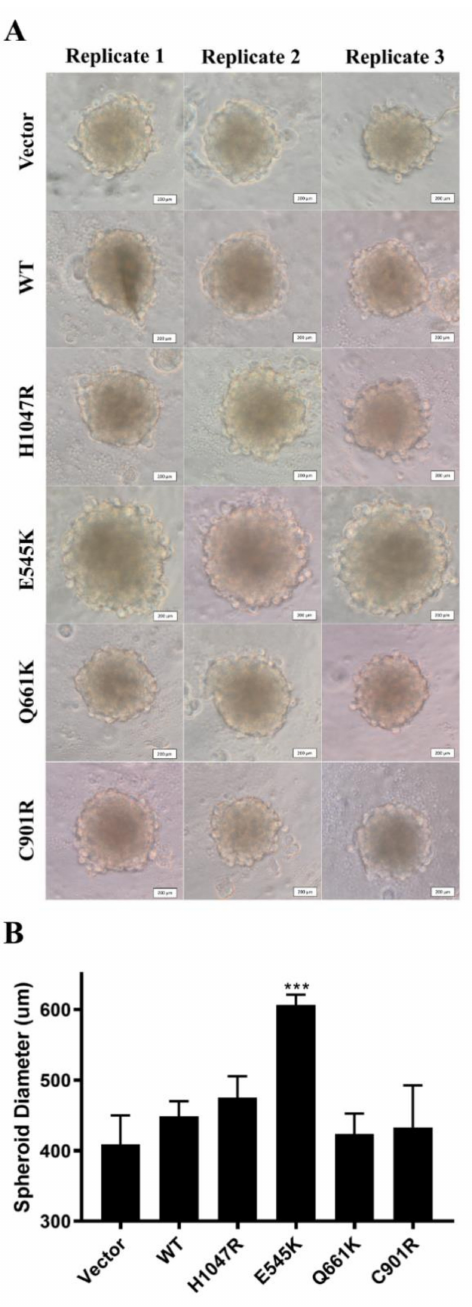
Figure 5. The E545K hotspot mutation, but not the other PIK3CA mutants and wild type, was able to enhance spheroid formation of NIH3T3 cells in vitro. ( A ) Micrographs of the spheroids at 96 h post-transfection show that there was a noticeable increase in the diameter of spheroids overexpressing the E545K hotspot mutation. Scale bar: 200 µ m. ( B ) Spheroid diameters were measured at 96 h post-transfection. Data presented are representative of three independent trials in triplicate, and expressed as mean ± standard deviation. *** p < 0.001. WT: wild type; PIK3CA: phosphatidylinositol 3-kinase, catalytic subunit